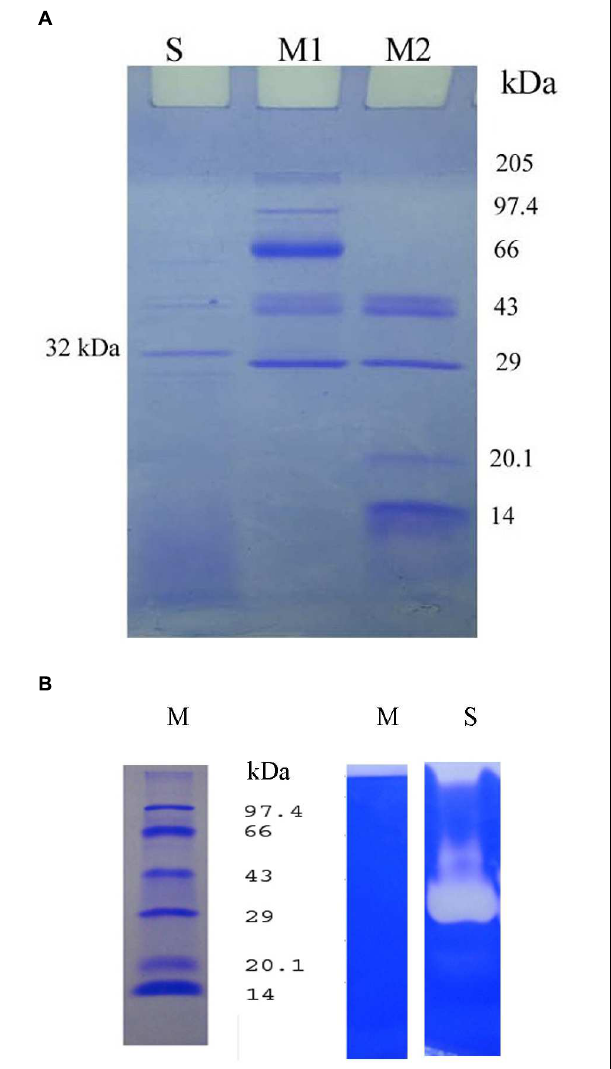
FIGURE 4 | Effect of pH vs. starch (A), pH vs. beef extract (B), and starch vs beef extract (C) on fibrinolytic enzyme production. Error bar represents standard deviation. FIGURE 5 | (A) Electrophoretic analysis of the crude enzyme from Bacillus sp.